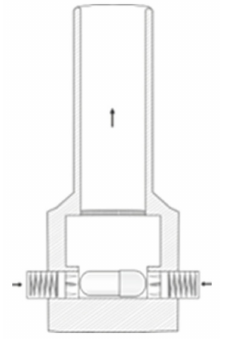
Figure 2. Schematic of the